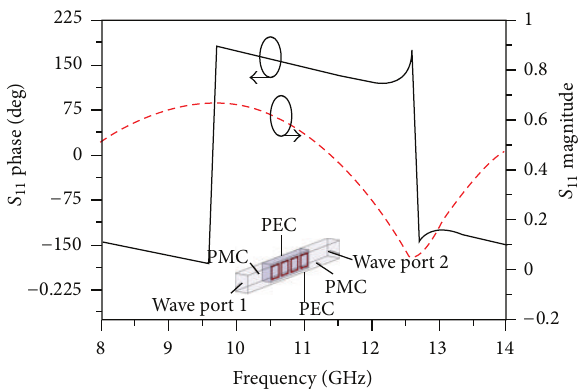
Figure 13: Reflection phase and magnitude of the LHM